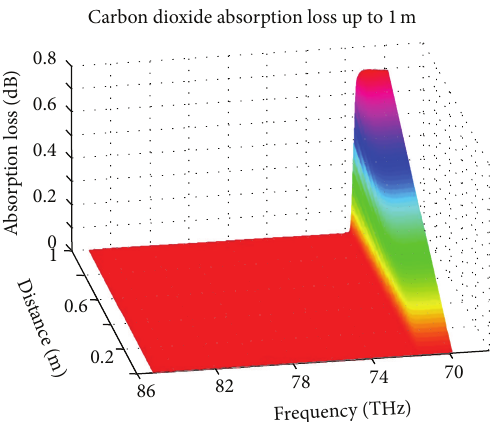
Figure 8: Infrared spectrum of CO 2 absorption loss up to 1 meter in the selected transmission